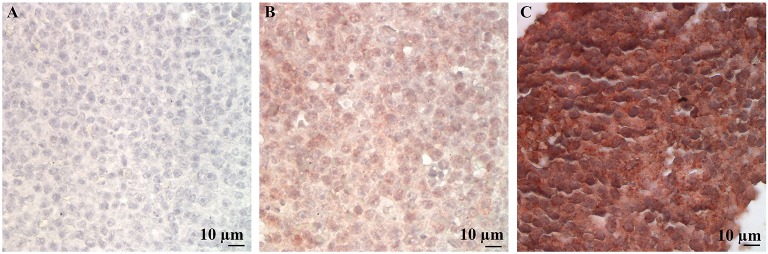
Representative LDL-R and SR-B1 staining of canine lymphoma cases and controls. High power (500X) images of a single representative case demonstrating no staining with the isotype control (A), weak staining for LDL-R (B) and strong staining for SR-B1 (C).